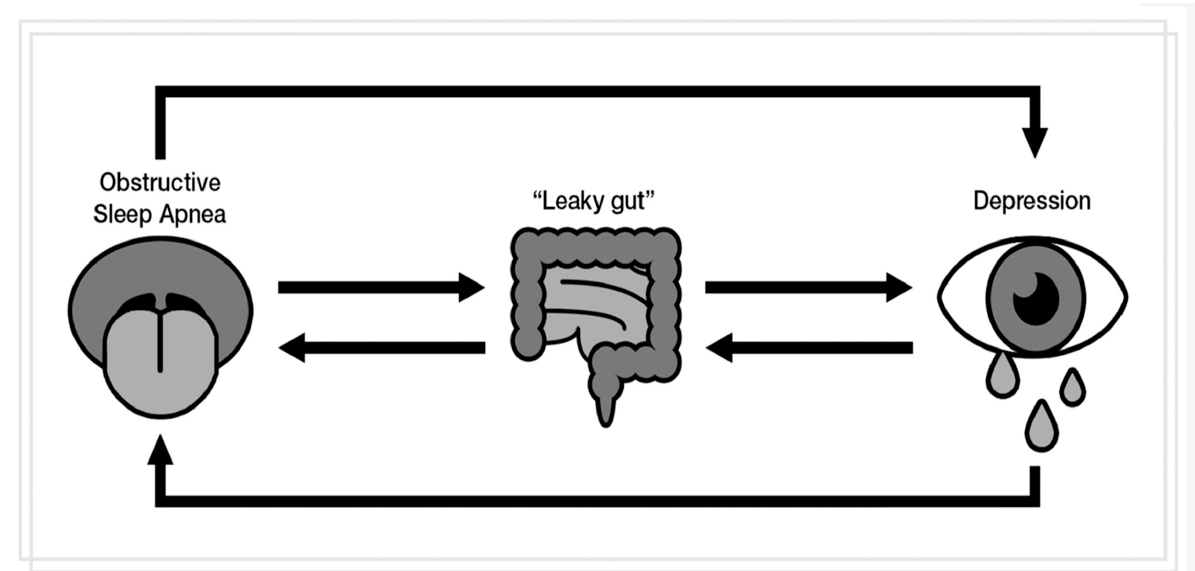
Figure 1. The simplified net of interconnections between OSA, depression and intestinal permeability. Strengths and